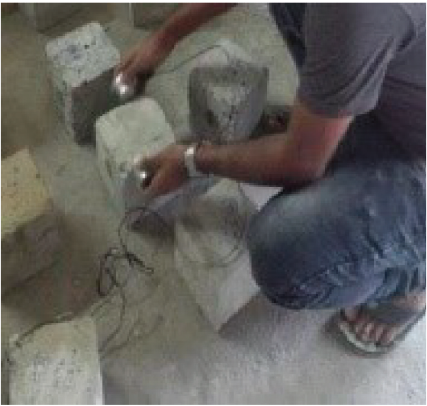
Figure 3: UPV test.